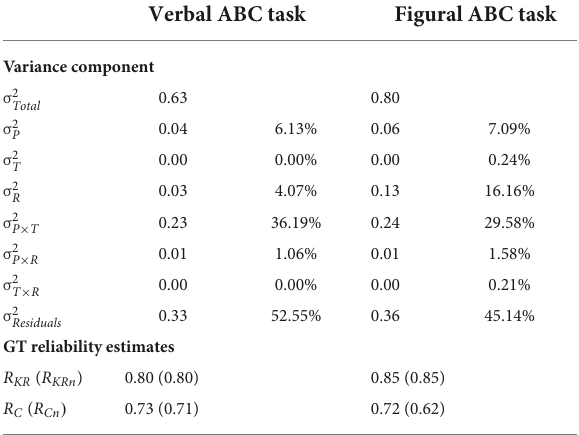
TABLE 1 Variance decomposition of creative abilities in the verbal and figural ABC task and summary of reliability estimates. Verbal ABC